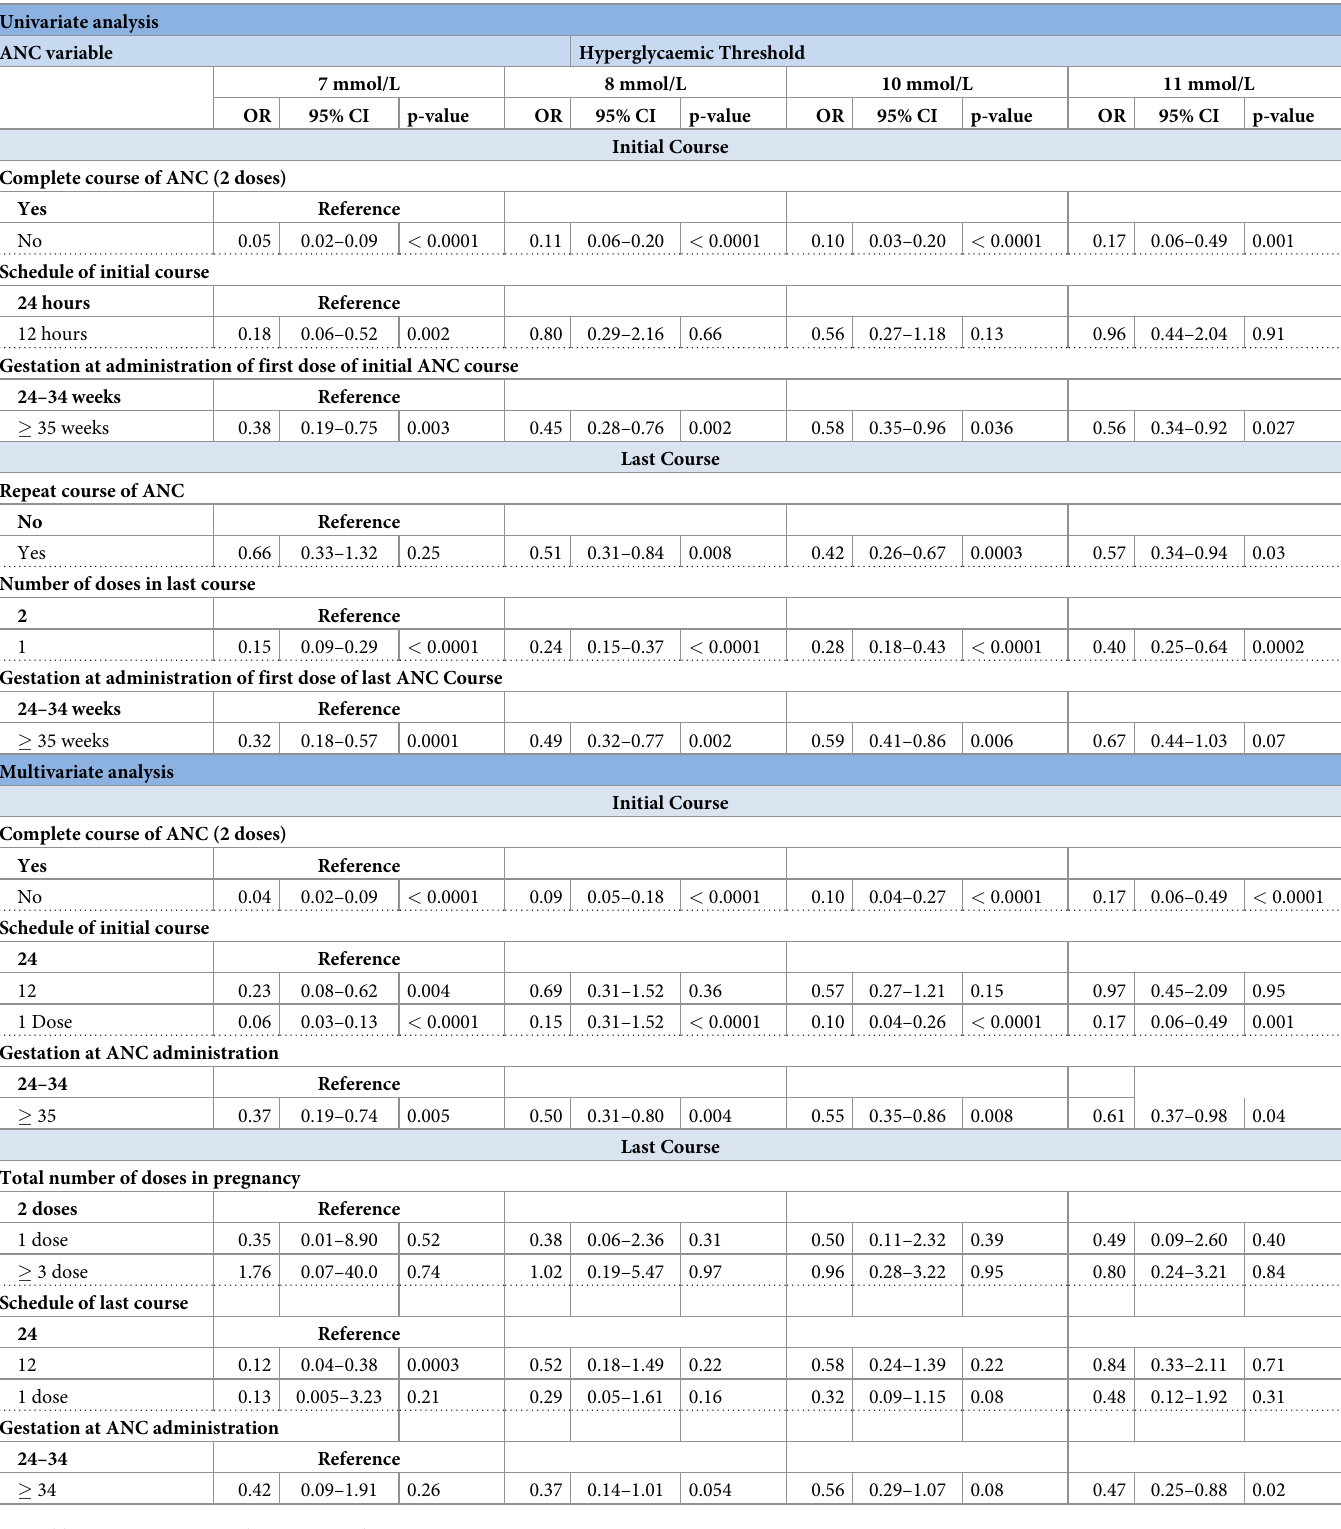
Table 2. Relationships between antenatal corticosteroid variables and the rate of maternal hyperglycaemia. Univariate